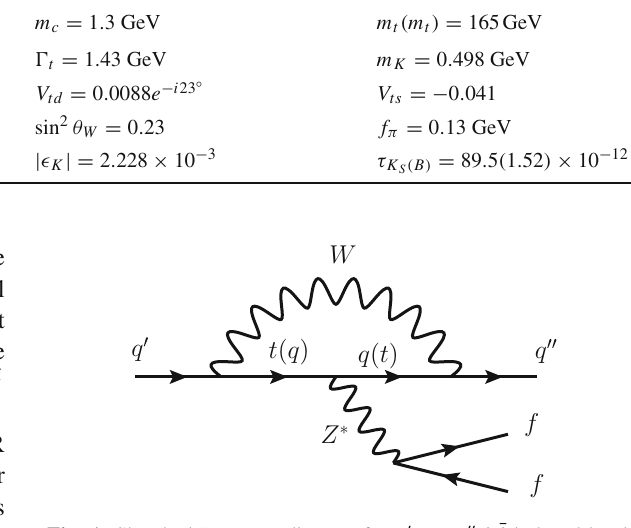
Fig. 1 Sketched Feynman diagram for q (cid:3) → q (cid:3)(cid:3) f ¯ f induced by the tqZ coupling, where q (cid:3) and q (cid:3)(cid:3) denote the down-type quarks; q = u , c , and f can be any possible